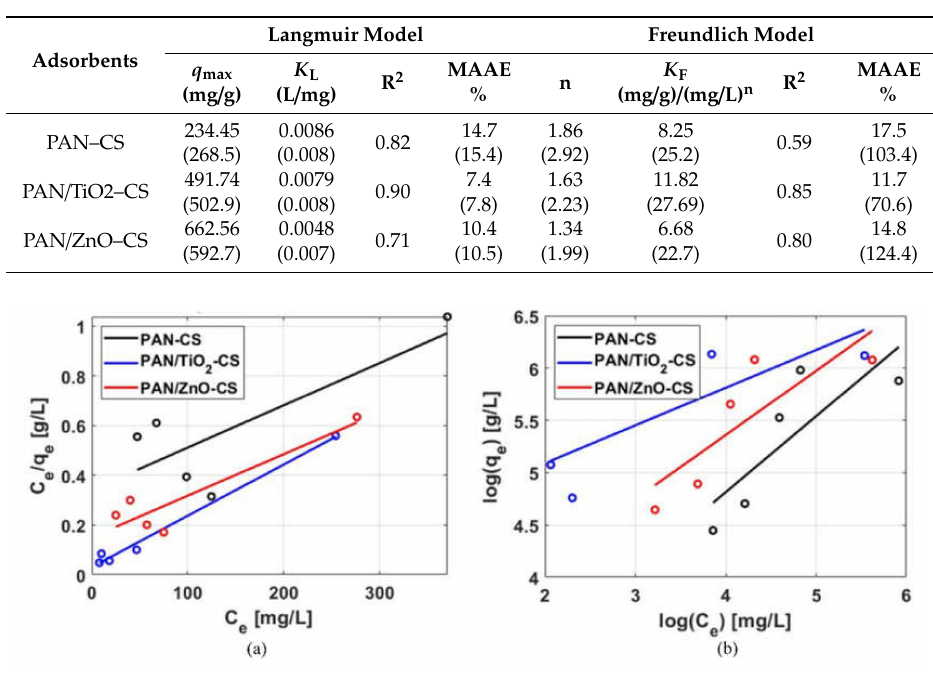
Figure 10. Isotherm models of ( a ) Langmuir and ( b ) Freundlich for lead ion adsorption using the bilayer nanofibers. Table 2. Parameters of Langmuir and Freundlich isotherms for the adsorption of lead by the bilayer nanofiber mats. The values between the parentheses represent the results obtained by the nonlinear optimization method.